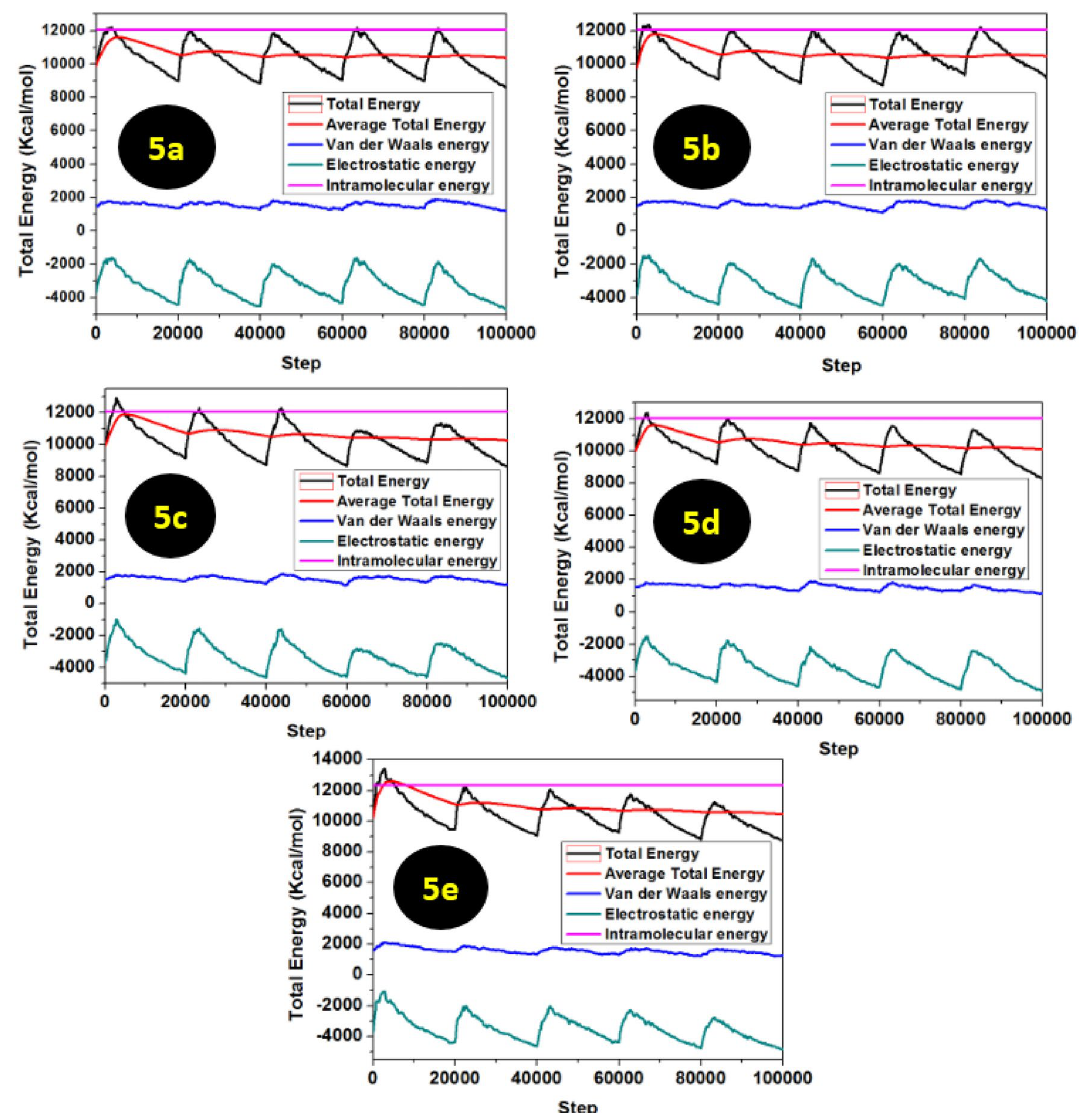
Figure 9. Energy fluctuation curves obtained from MC simulations for 5a – e